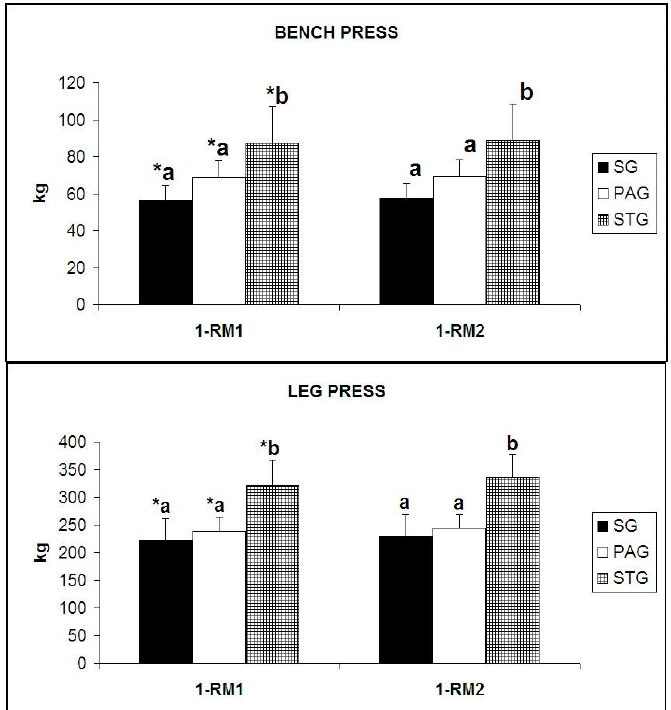
Figure 1. Comparison between 1-RM1 and 1-RM2 tests in sedentary, physical active and strength-trained groups for bench press and leg press